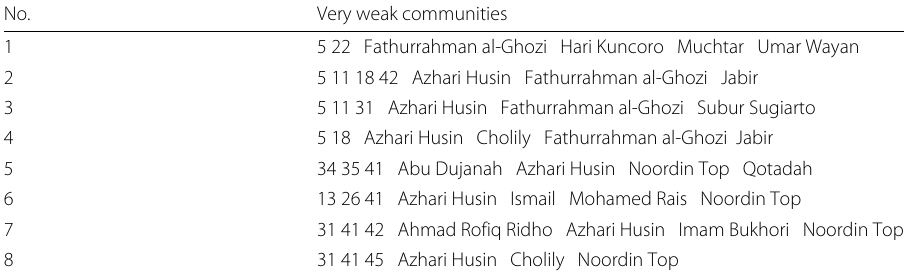
Table 5 The 8 very weak communities identified using MaxBic in Noordin Top terrorist network No. Very weak